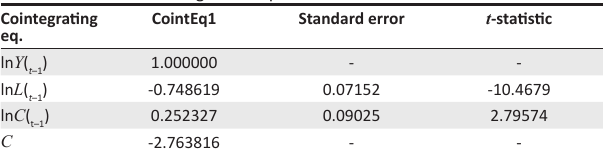
TABLE 5: Results of cointegration equation.